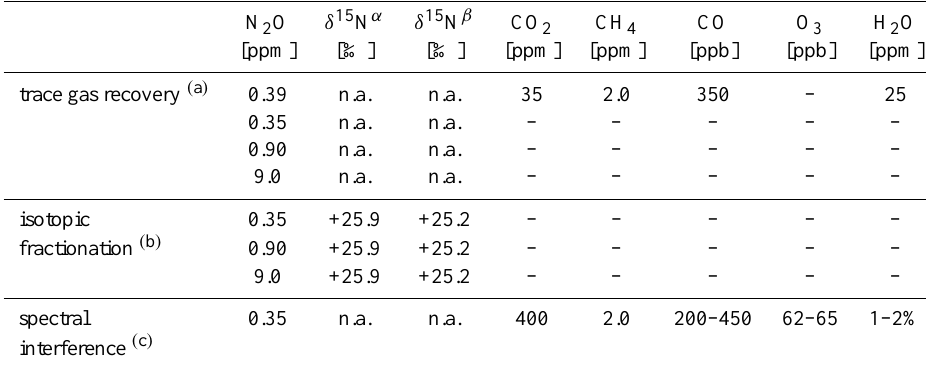
Table 1. Trace gas mixing ratios and N 2 O isotopic